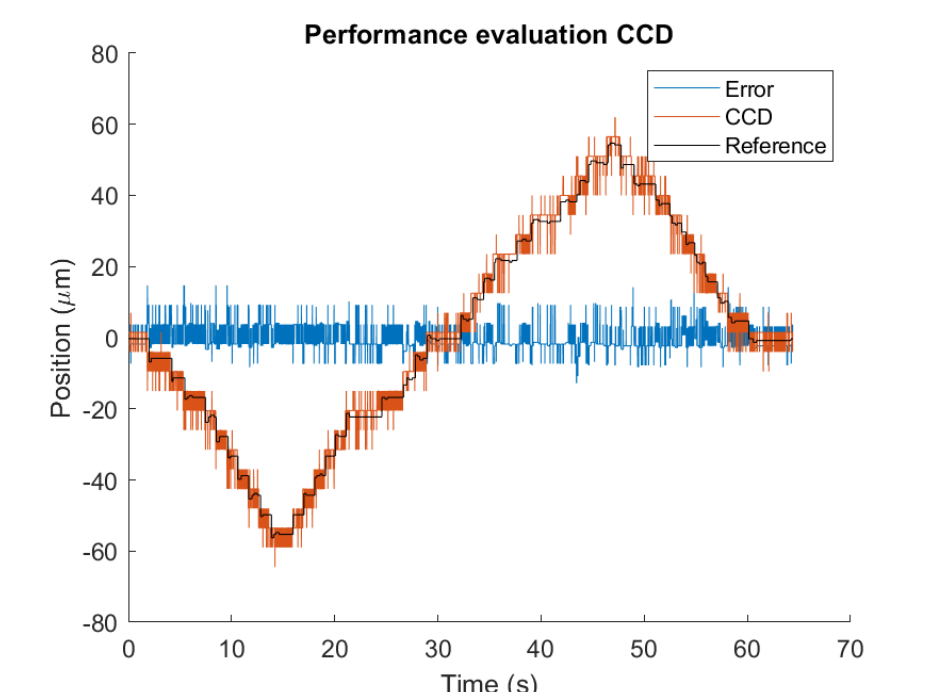
Figure 20. Performance of CCD sensor analysed for linearity. RMS error value 3.0µm.